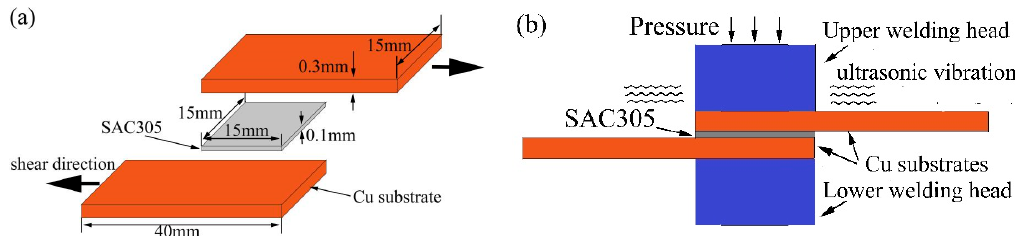
Figure 1. ( a ) Schematic of the Cu/SAC305/Cu sandwich structure and ( b ) the ultrasonic bonding principle.